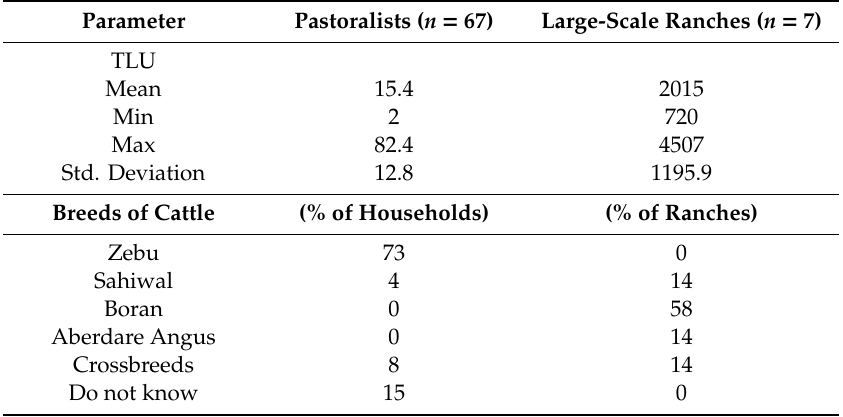
Table 1. Average TLU and breeds of cattle for pastoralists and large-scale